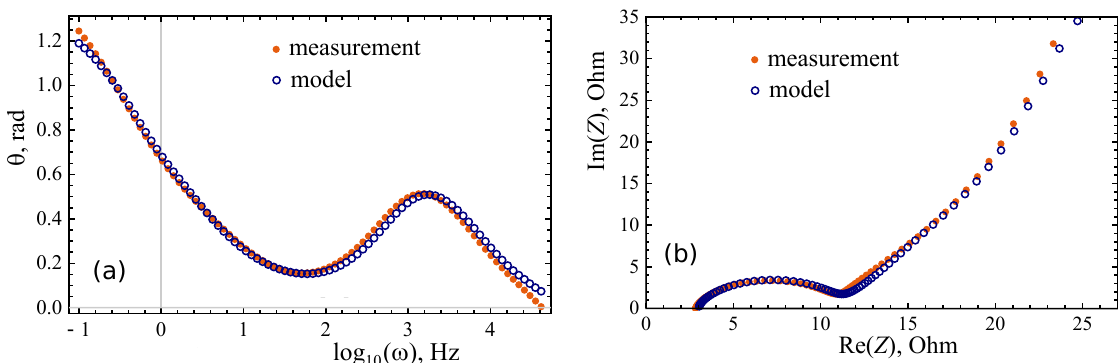
Figure 8. Nyquist ( a ) and Bode ( b ) plots of measured and modeled impedance spectra for PANI-MWCNT pseudo-capacitor at room temperature.